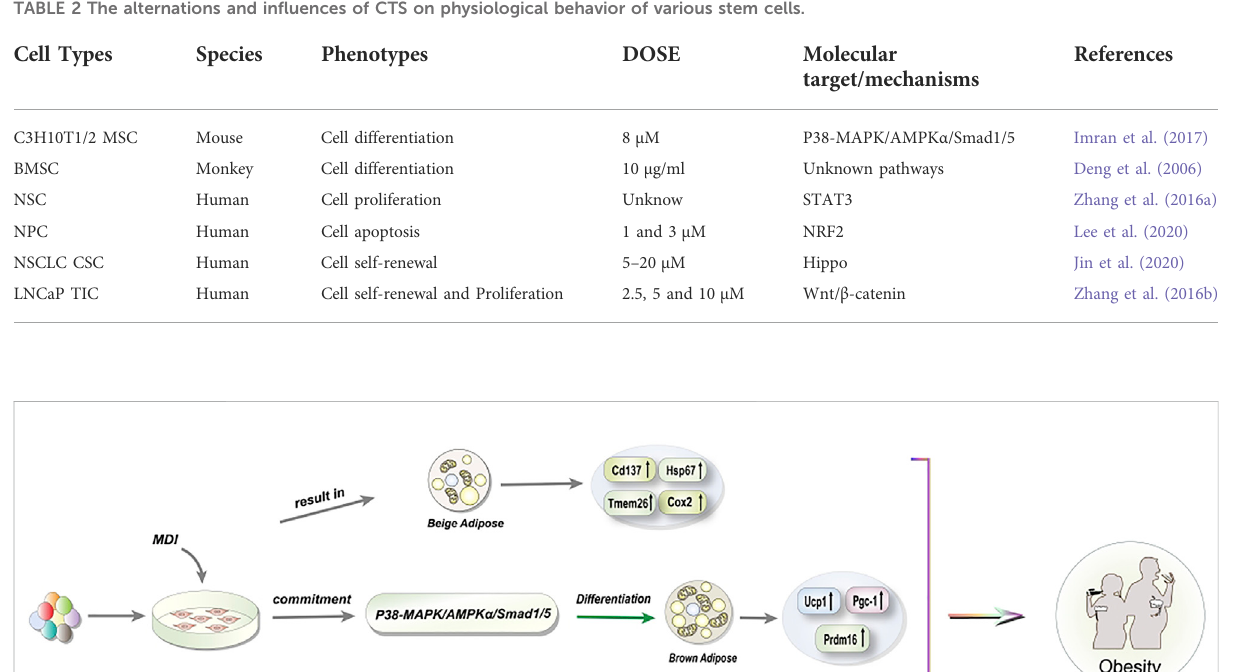
TABLE 2 The alternations and in fl uences of CTS on physiological behavior of various stem